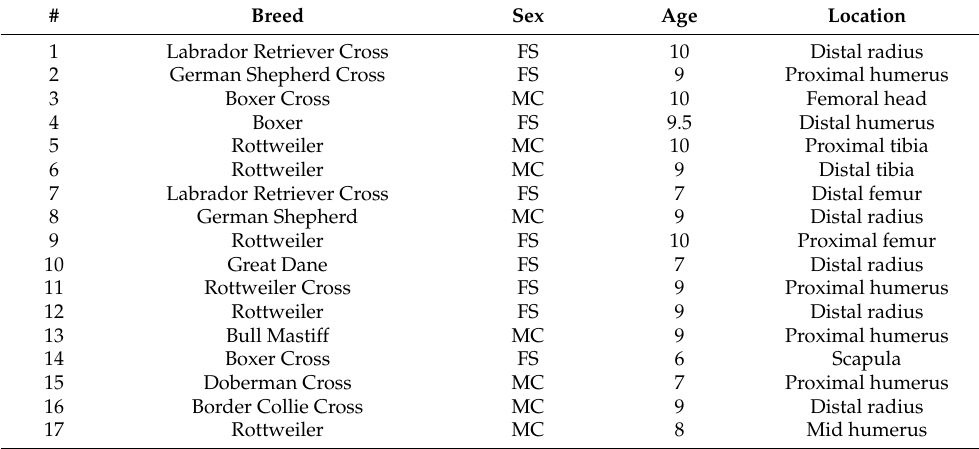
Table 2. Summary table including signalment (breed, sex, neuter status, age) and tumor location of 34 dogs with appendicular OS; FS, female spayed; F, Female intact; MC, Male castrated; M, Male